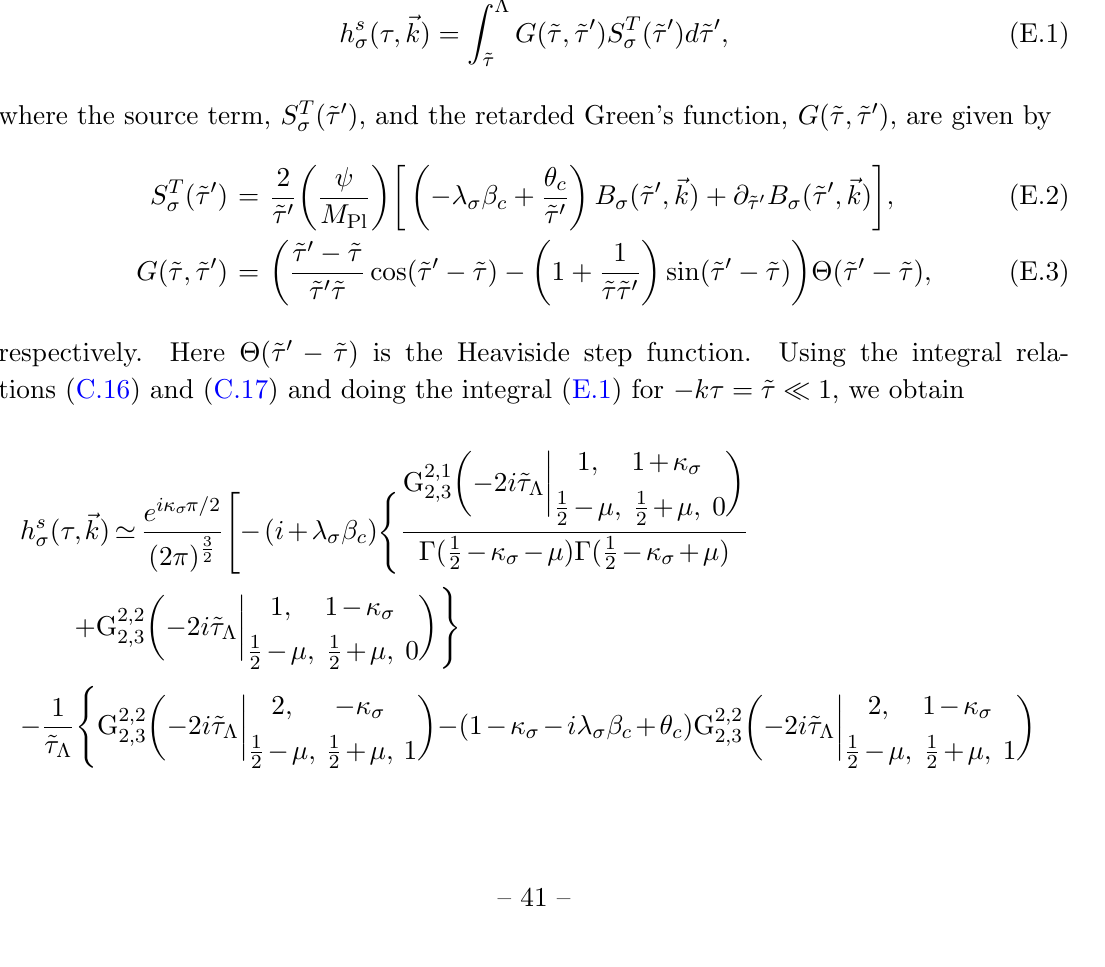
Figure 15 . The ratio (cid:1) (cid:17) physical momentum in which the deviation from adiabaticity is (cid:10) + (~ (cid:28) IR ) = 0 : 1. The ratio (cid:1) for the minus polarization is smaller with the same order of